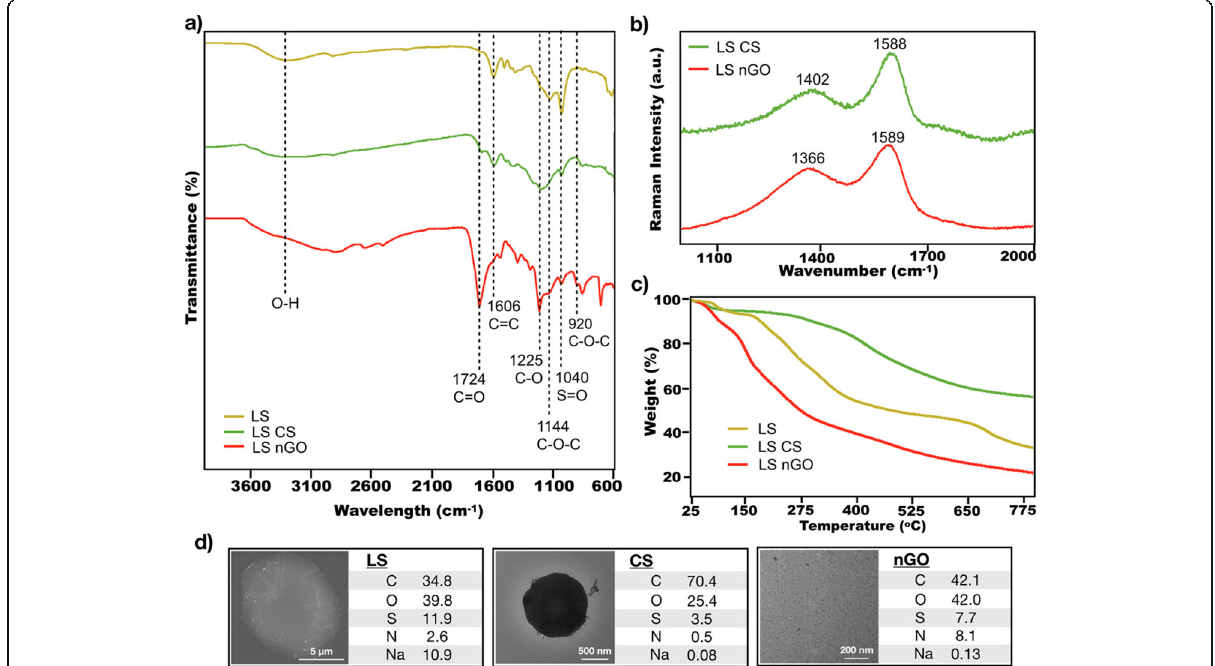
Fig. 1 a FT-IR spectra, b Raman spectra, c TGA curves, and d SEM and TEM images and elemental compositions of lignosulfonate (LS) and LS- derived carbon products – carbon spheres (CS) and nanographene oxide